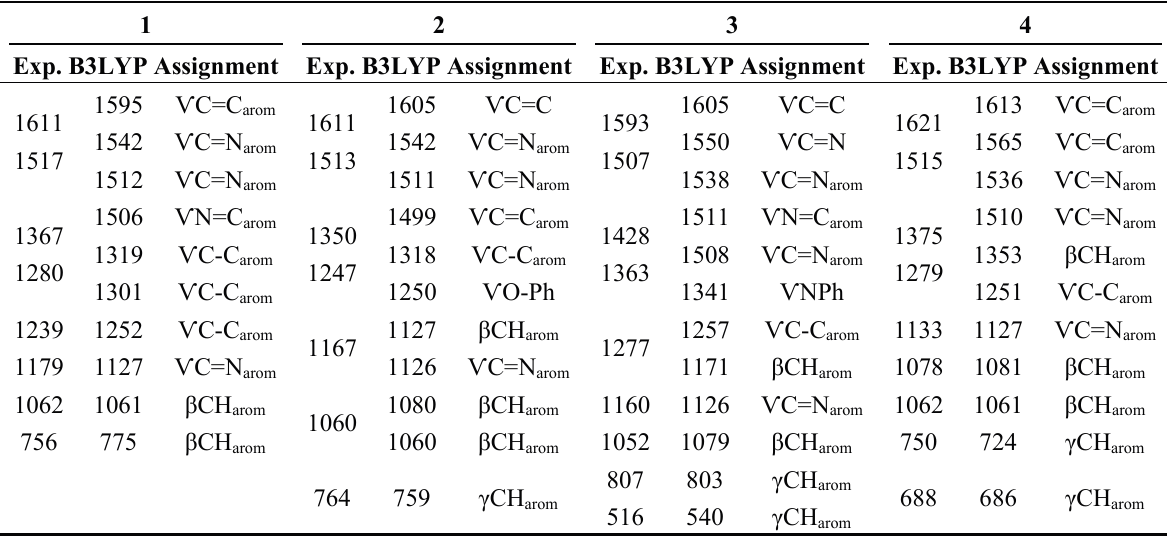
Table 7. Prominent experimental and simulated vibrational (cm − 1 ) values of 1 – 4